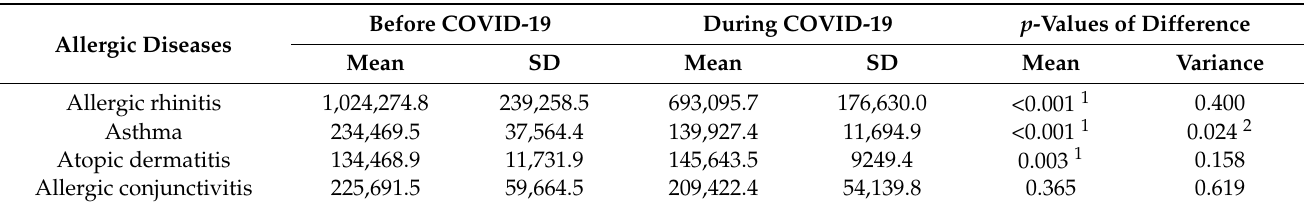
Table 1. Monthly numbers of patients treated for allergic diseases before and during the COVID ‐ 19 pandemic and their differences.